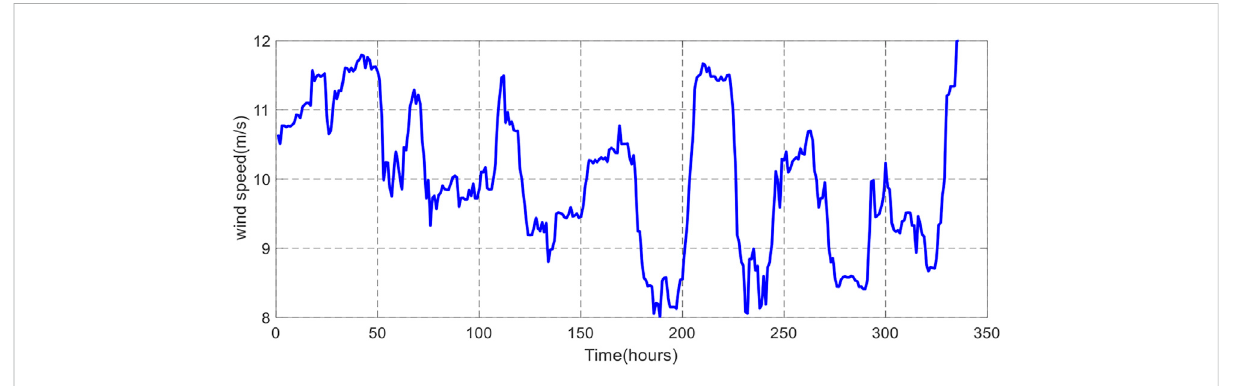
FIGURE 12 Wind speed (7